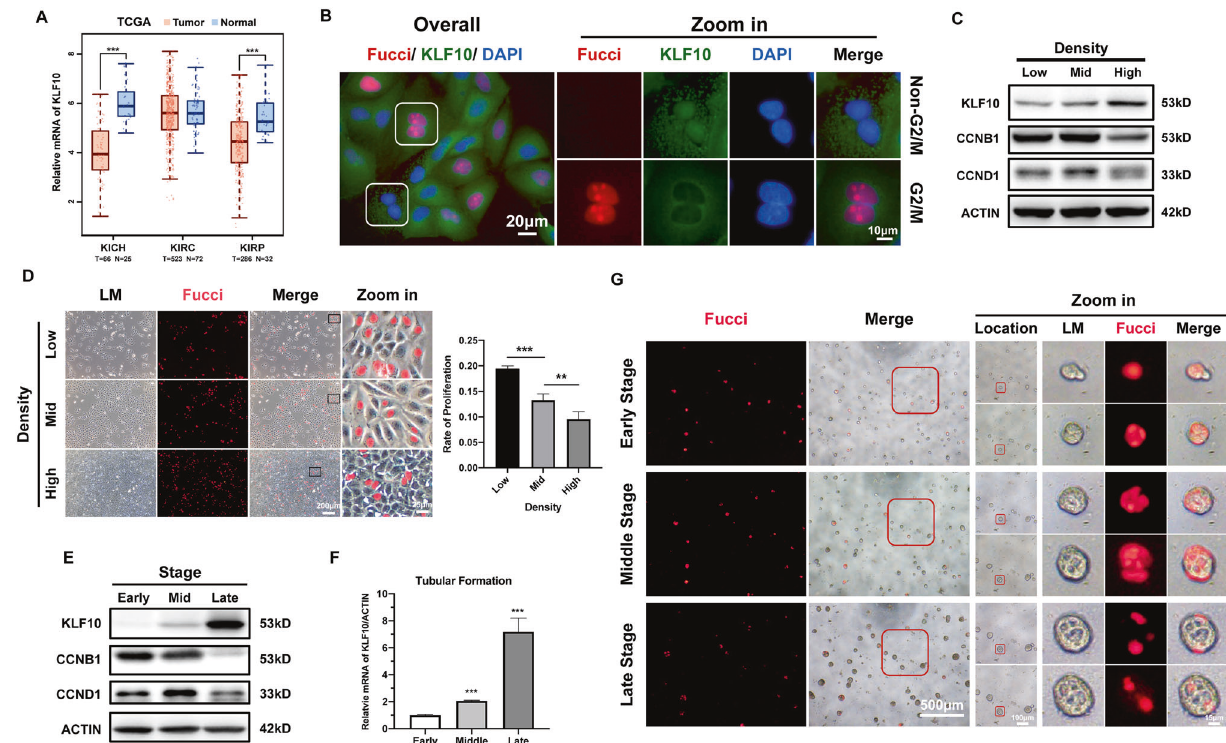
chromophobe; KIRC, Kidney renal clear cell carcinoma; KIRP, Kidney renal papillary cell carcinoma. B Representative immuno fl uorescence staining image of KLF10 and Fucci in 2D cultured renal tubular cells. C Representative immunoblot analysis of KLF10, CCNB1 and CCND1 in low-/middle-/high-density group. ACTIN served as the standard. D Representative fl uorescence image of Fucci in low-/middle-/high-density group. Rate of proliferation was calculated via percentage of Fucci positive cells. E Representative immunoblot analysis of KLF10, CCNB1